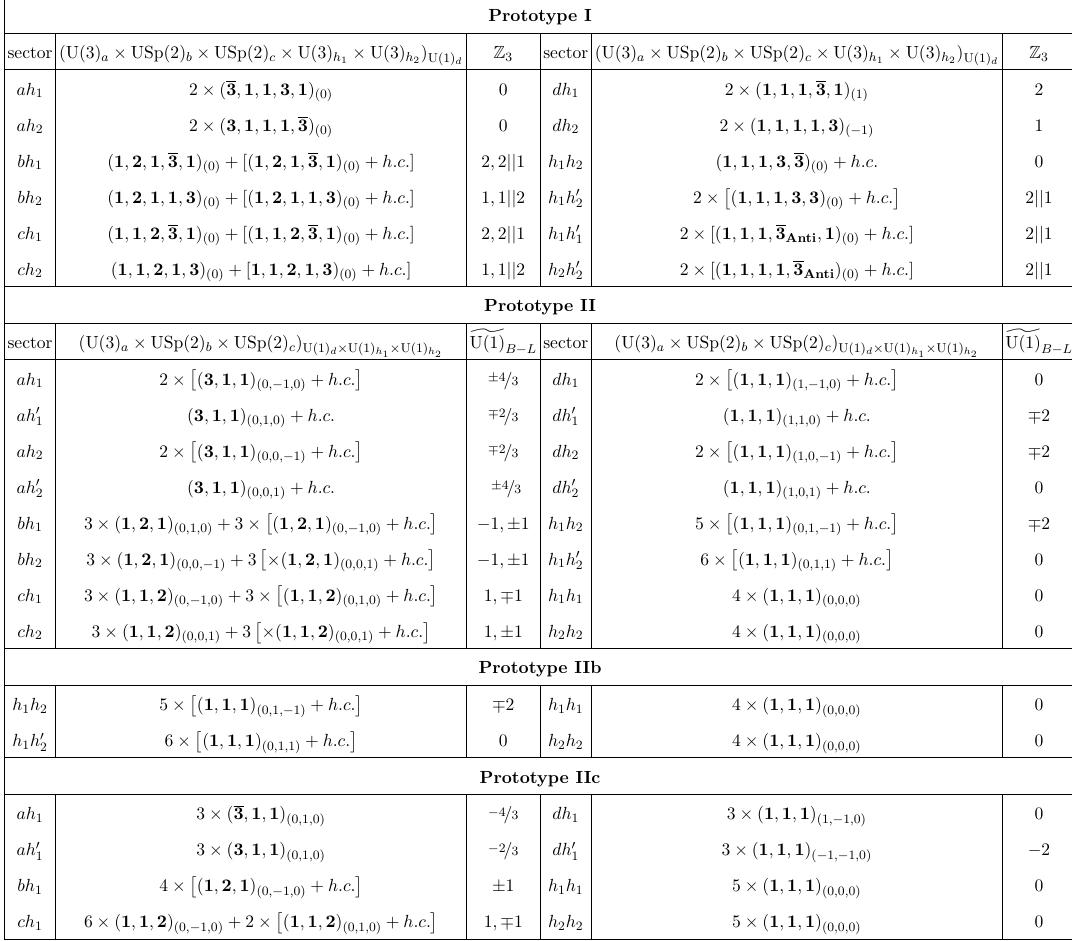
Table 20 . ‘Hidden’ massless spectrum per L-R symmetric model completing the common observ- able sector displayed in table